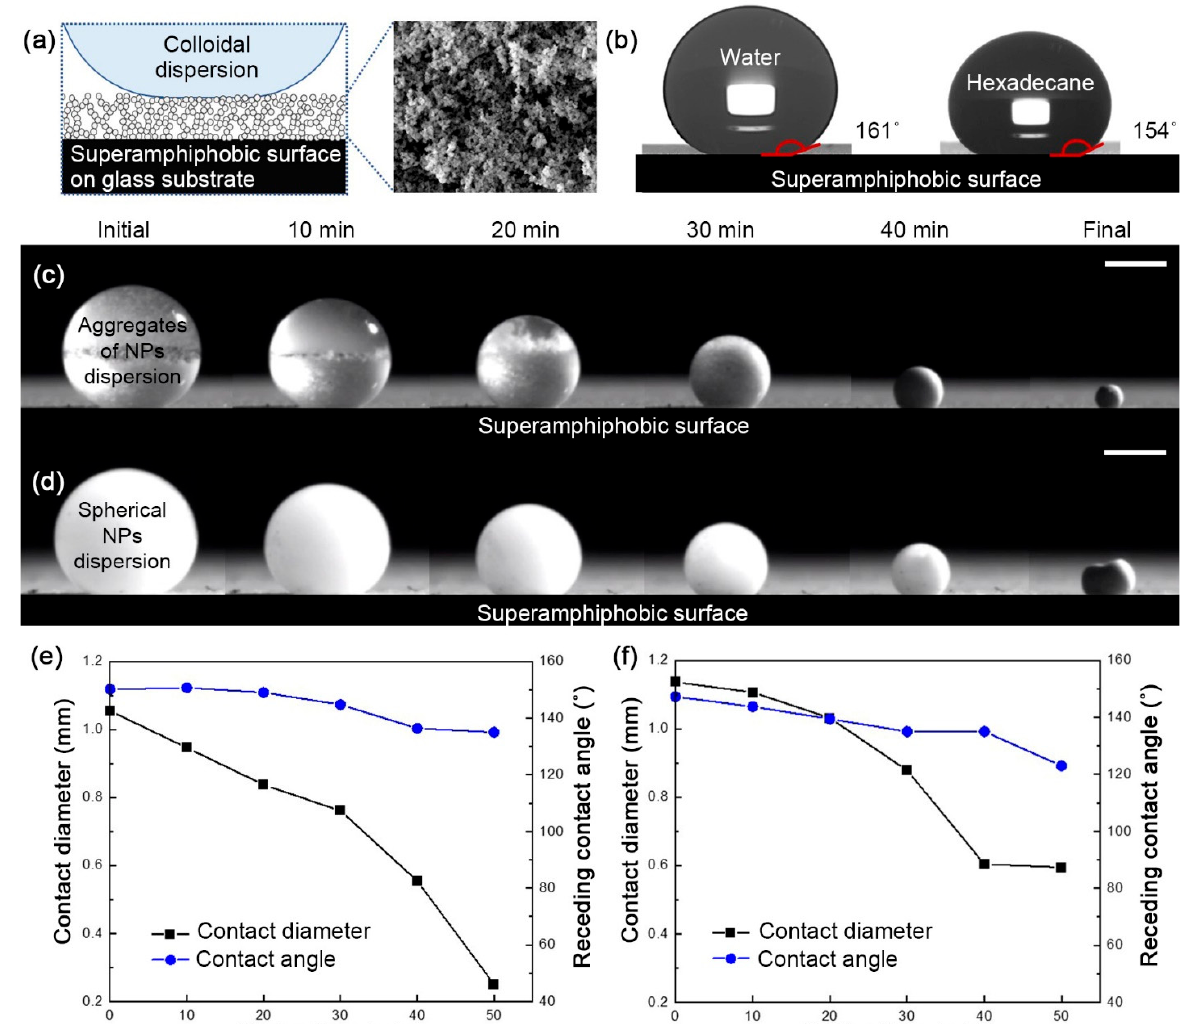
Figure 2. Supraparticle synthesis by evaporation-driven surface templated synthesis. ( a ) Structure of the soot-templated superamphiphobic surface characterized by SEM (left), and a schematic of the colloidal dispersion drop on the superamphiphobic surface with high static contact angle. ( b ) Static contact angles of water and hexadecane drops on the superamphiphobic surface. Time snap- shots of drying colloidal aqueous dispersion of ( c ) aggregates of NPs (concentration: 0.2 vol %) and ( d ) spherical NPs (concentration: 2 vol %) drop on the superamphiphobic surface. ( e ) Contact angle and contact diameter of TiO 2 supraparticle over drying times given in ( c ). ( f ) Contact angle and contact diameter of the silica supraparticle over drying times given in ( d ). The scale bars are 1 μ m for ( a ) and 1 mm for ( c , d ).